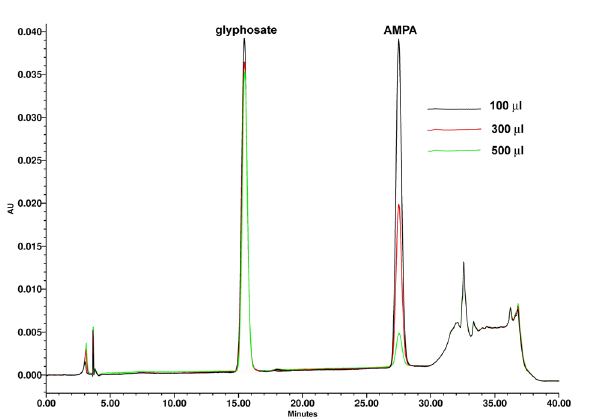
Figure 1: Relative glyphosate and AMPA response vs. hypochlorite concentration as oxidative reagent (μL of 5% sodium hypochlorite in 1 L of water). Table 1: Optimised MRM transitions by direct ESI source infusion.